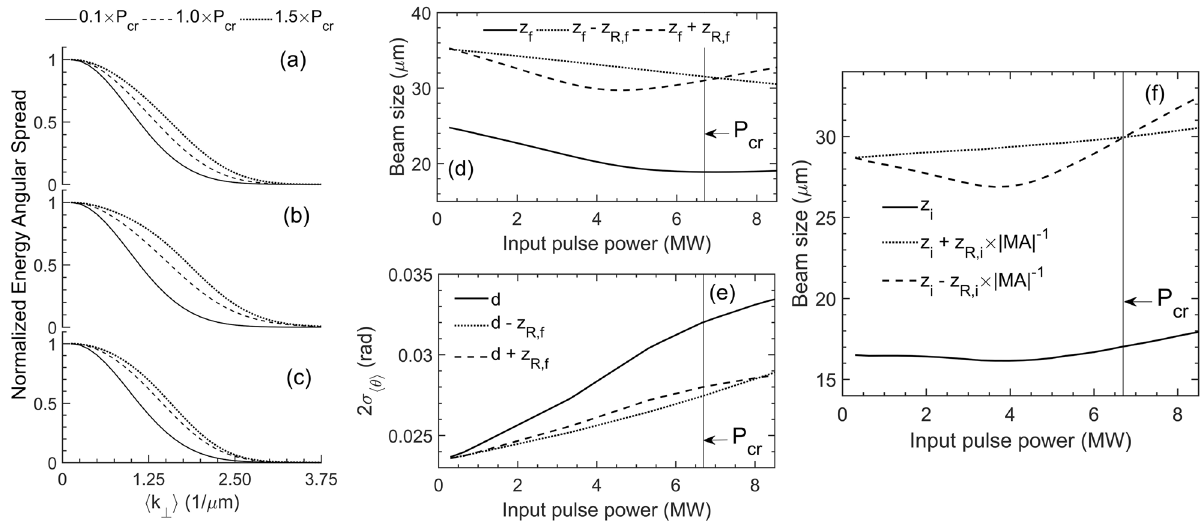
Figure 4. Numerical calculations based on Eqs. (3) and (4) (“Methods”) in water. (a–c) show the time- integrated and normalized far-field spectra S ( t, k ⊥ ) versus the time-averaged instantaneous transverse wavenumber � k ⊥ � , calculated by the Hankel transformation of the solution of Eqs. (3) and (4) at (a) z = z f − z R,f , (b) z = z f and (c) z = z f + z R,f respectively. The distributions are identified as the radiant energy angular spread, understood as the far-field counterpart of the pulse fluence (radiant energy exposure). (d) Beam size inside the propagation medium (near the focal plane of L1) versus input pulse power. (e) The standard deviation of � k ⊥ � taken from (a–c) has been used to calculate the standard deviation of divergence (cid:31) θ (cid:30) of the beam as a function of the input power at a distance d from reference z = z f = 0 (first-order approximation). (f) Calculated imaged beam size in the far-field versus the input pulse power (first-order